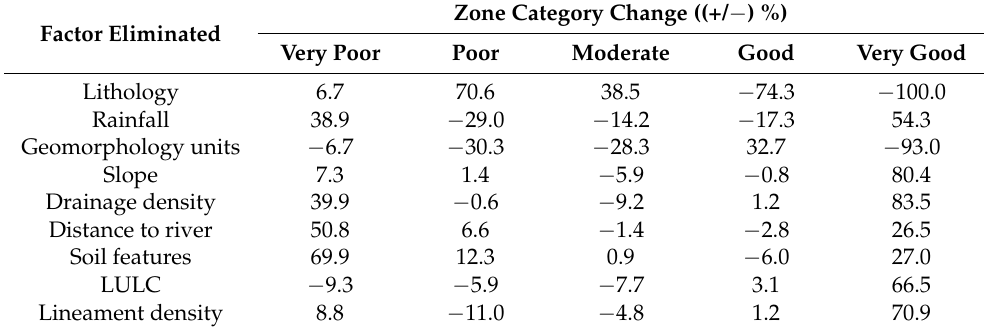
Table 9. Zone category change under the elimination of each